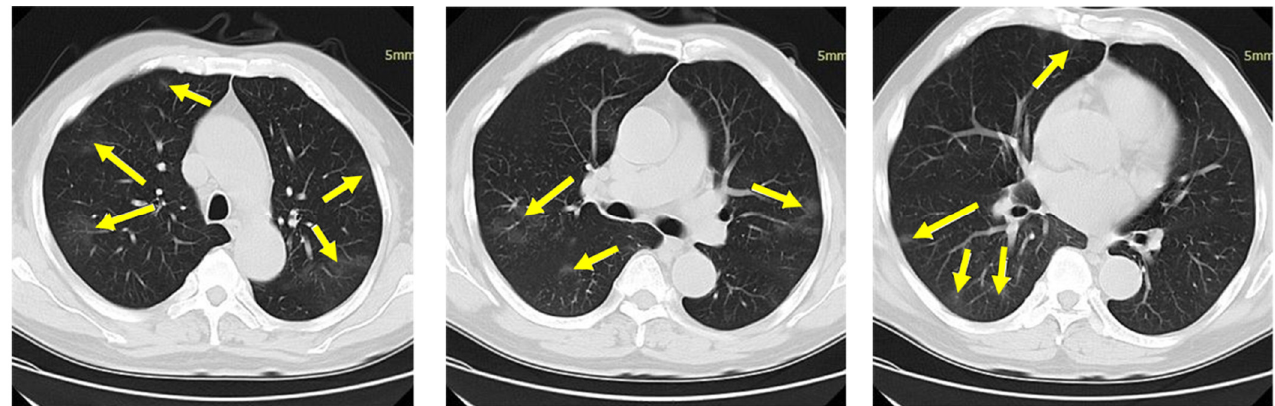
Figure 7. All CT images of a single CT case are shown here. The center of infection in the image is indicated by arrows.